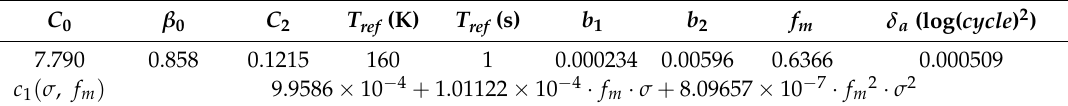
Table 2. The coefficients of the explicit formulation for 63Sn37Pb solder.